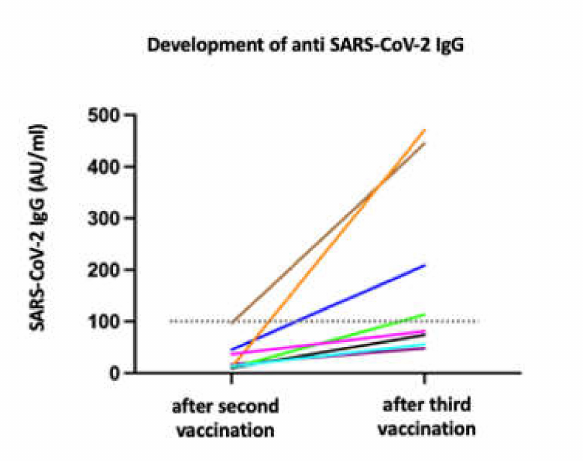
Figure 1. Increase of anti–receptor-binding domain (RBG) IgG antibody titers after the third vaccina- tion against SARS-CoV-2. The horizontal dotted line indicates the cut-off for protection (100 arbitrary units